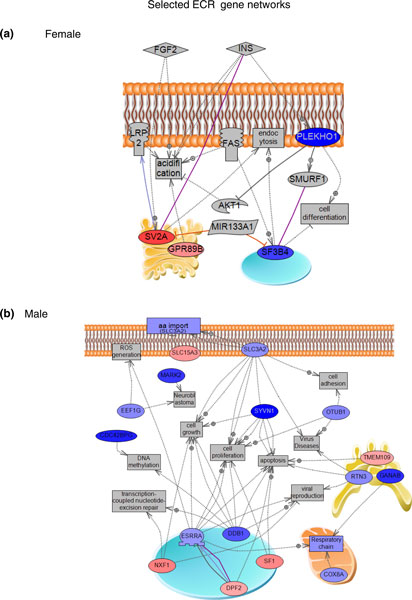
Shortest cell processes connection gene sub-networks for genes of selected female ECR
chr2-188.8 and male ECR chr1-204.75. (a) ECR chr2-188.8. (b) Male ECR chr1-204.75.
Node shapes: oval and circle, protein; diamond, ligand; circle/oval on tripod platform,
transcription factor; ice cream cone, receptor; crescent, kinase or protein kinase; irregular
polygon, phosphatase. Color code: red, up-regulated genes; blue, down-regulated genes. Arrows with a
plus sign indicate positive regulation/activation; arrows with a minus sign indicate negative
regulation/inhibition; grey arrows represent regulation; lilac arrows represent expression; purple
arrows represent binding; green arrows represent promoter binding; yellow arrows represent protein
modification. AA, amino acid; FAS; FGF, fibroblast growth factor; INS, insulin; LRP2, low density
lipoprotein receptor-related protein 2; ROS, reactive oxygen species.